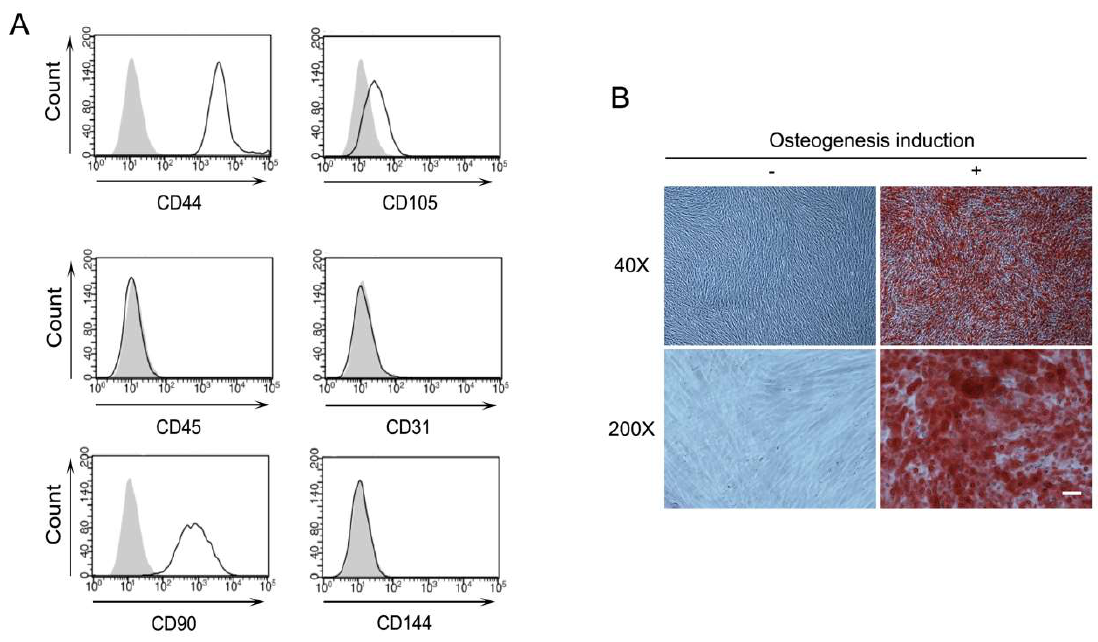
Figure 1. Characterization of periodontal ligament stem cells (PDLSCs). ( A ) Expression of cell surface markers of PDLSCs. Indicated cell surface proteins of PDLSCs were analyzed by flow cytometry. Gray and white areas represent the isotype control and each indicated antibody. ( B ) Osteogenesis of PDLSCs. Mineral deposition after osteogenic differentiation of PDLSCs. Cells were stained with alizarin red S. − : culture media, +: osteogenic differentiation media, magnification, 40 × and 200 × . Scale bar = 100 μm.